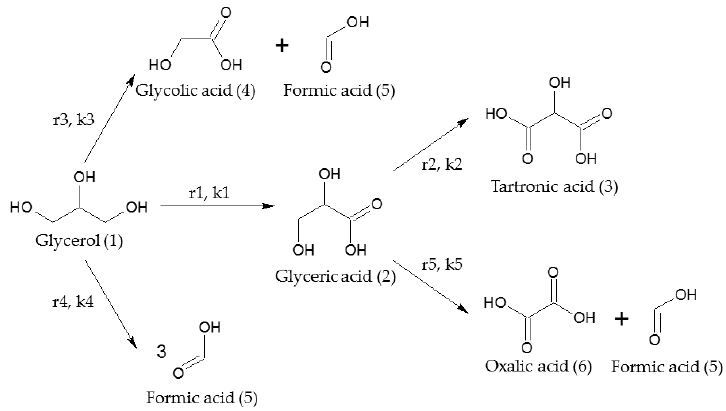
Figure 3. Proposed reaction pathways of GLY oxidation [21].